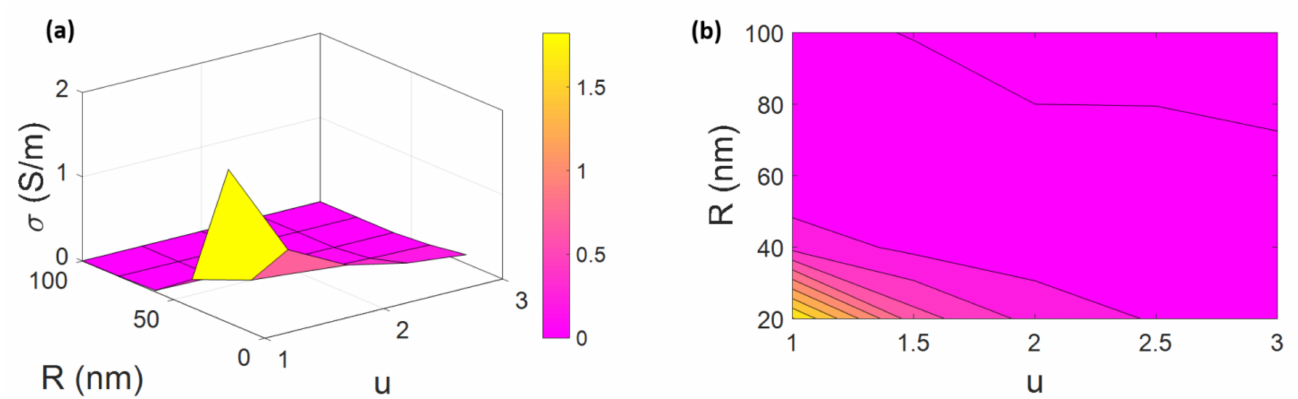
Figure 4. The stimuli of “ u “ and “ R “ on the conductivity by ( a ) 3D and ( b ) 2D designs. Thin nanofibers positively influence the percolation onset, effective volume fraction of CNFs, and the percentage of percolated CNFs based on Equations (2), (5), and (6), respectively. The lower values of CNF radius decrease the percolation onset, increase the